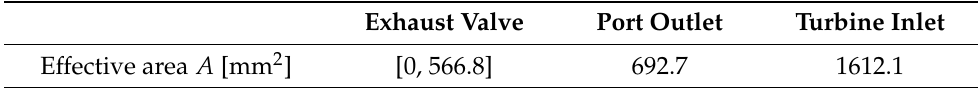
Figure 4. The effective area and valve lift of exhaust valve with the flow Mach number under two operating conditions: (a) 1300 rpm/17.8 nIMEP; (b) 900 rpm/11.5 nIMEP. Table 3. Effective areas of measurement